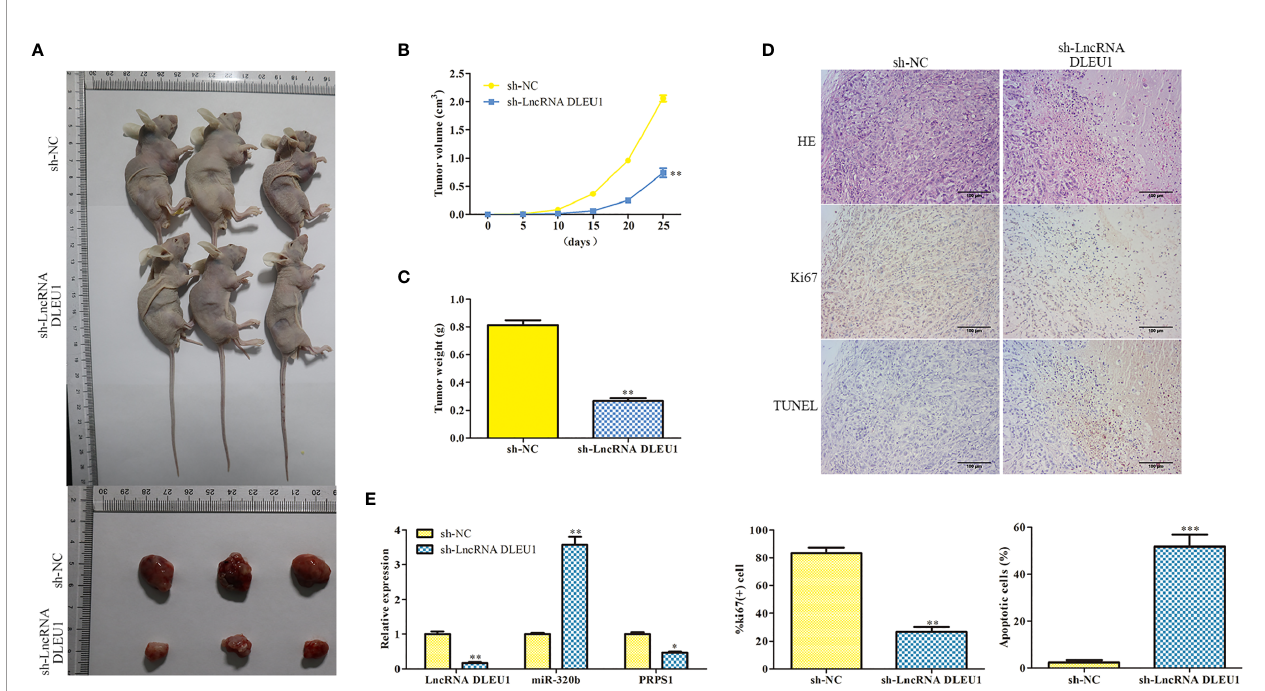
FIGURE 8 | Inhibition of DLEU1 suppresses tumor growth in vivo. (A) Representative images of xenograft tumors. (B) Tumor growth curve. (C) Tumor weight. (D) Cell necrosis, the Ki-67 expression and cell apoptosis were determined using HE, IHC and TUNEL assay, respectively. (E) The expression of DLEU1, miR-320b and PRPS1 were determined by qRT-PCR. * P < 0.05, ** P < 0.01, *** P < 0.001 vs .